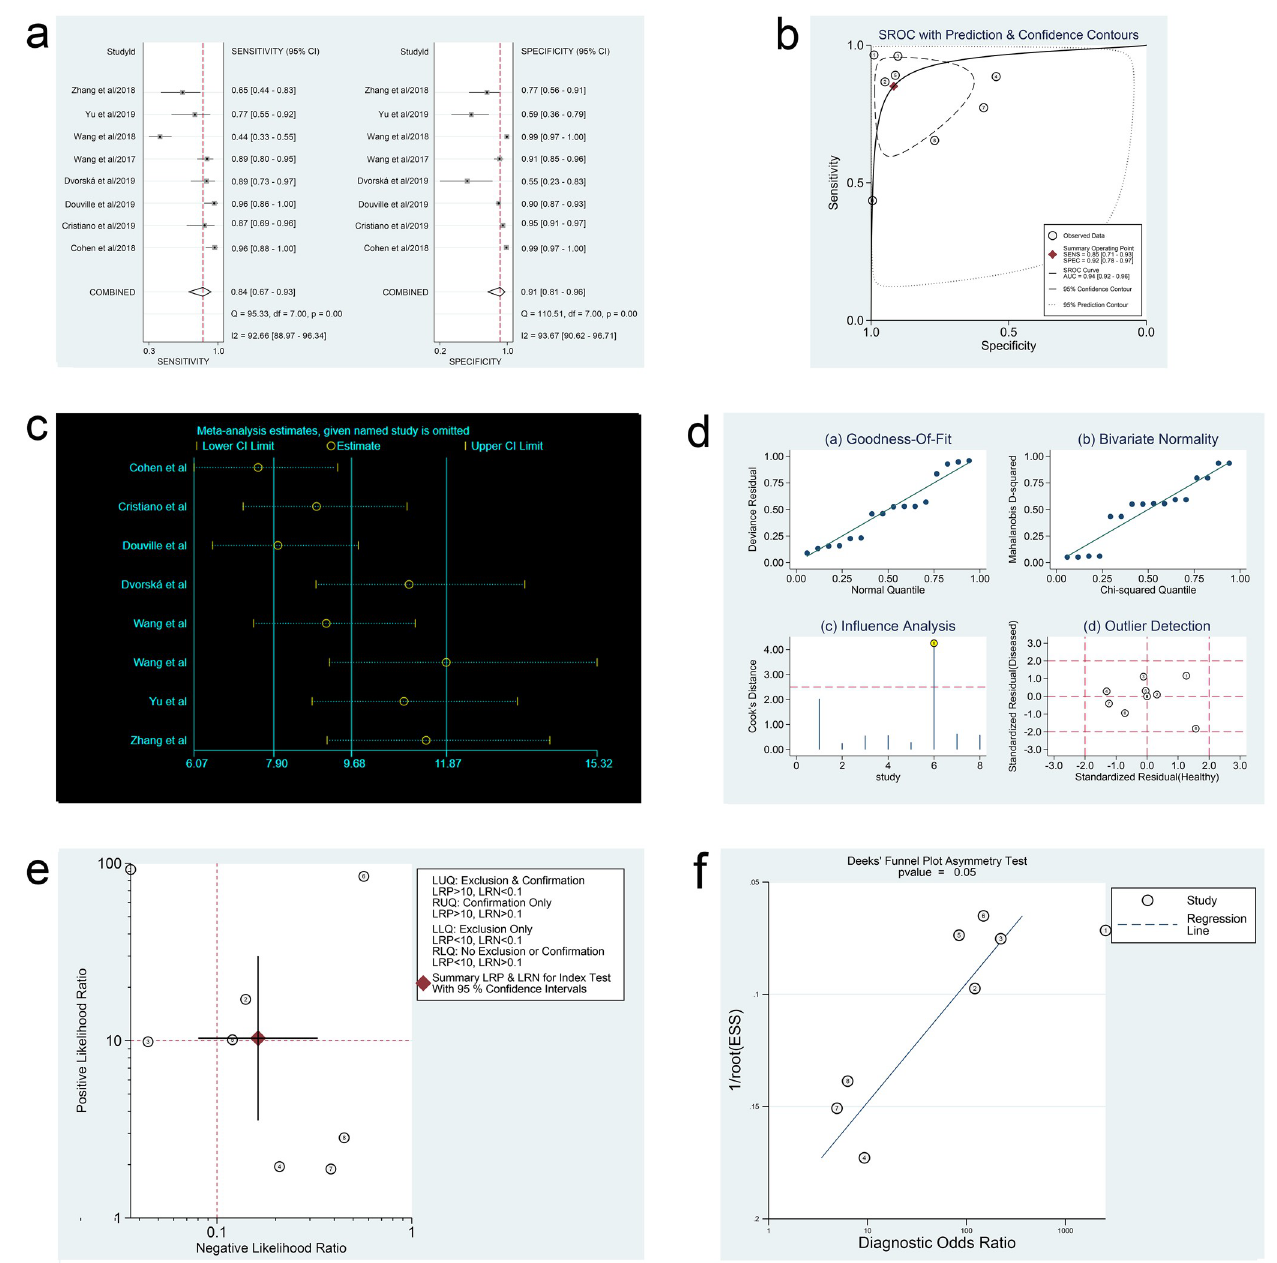
Fig 2. Forest plots of sensitivity and specificity, SROC curve, sensitivity analysis plot, goodness-of-fit and bivariate normality analysis plots, likelihood ratio plot and Deeks’ funnel plot of ctDNA. (a) Forest plots of sensitivity and specificity to evaluate the diagnostic performance of ctDNA. (b) SROC curve to describe the diagnostic value of ctDNA. (c) Sensitivity analysis to estimate each study’s value of ctDNA. (d) Goodness-of-fit and bivariate normality analysis plots to explore the sources of heterogeneity of ctDNA. (e) Likelihood ratio plot to appraise the diagnostic and elimination capabilities of ctDNA. (f) Deeks’ funnel plot to assess publication bias of